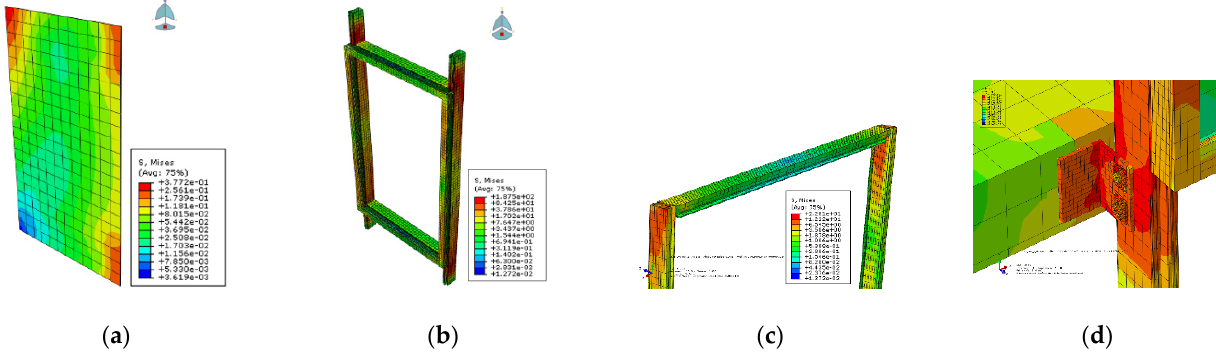
Figure 22. Stress distribution in each member of non-seismic curtain wall during Z -axis drift: ( a ) glass; ( b ) aluminum; ( c ) PVC; ( d )